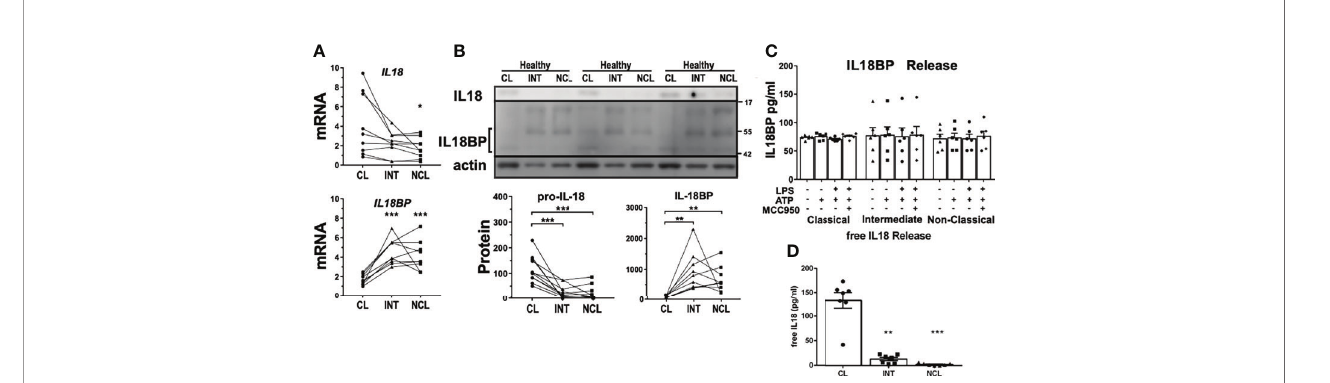
FIGURE 4 | Differential expression pro fi le of IL18 gene as a potential explanation for variation of in fl ammatory interleukin release. (A) Basal mRNA and (B) protein expression pro fi les of IL18 and IL18BP in monocyte subpopulations of healthy donors. IL18 expression was signi fi cantly higher in classical monocytes while intracellular glycosylated IL18BP protein levels (~45-50 kDa) were higher in intermediate and non-classical monocytes (n = 9-11). At least two bands were detected that would correspond to different IL18BP isoforms. (C) Unlike IL18, IL18BP release into the supernatant from monocyte subpopulations upon treatments, was unaffected by in fl ammatory stimulation (n = 6). (D) Therefore, active free IL18 using calculated IL18BP sequestration resulted in practically the same IL18 concentrations measured in Figure 3A ; * compared to classical; *p < 0.05; **p ≤ 0.01; ***p ≤